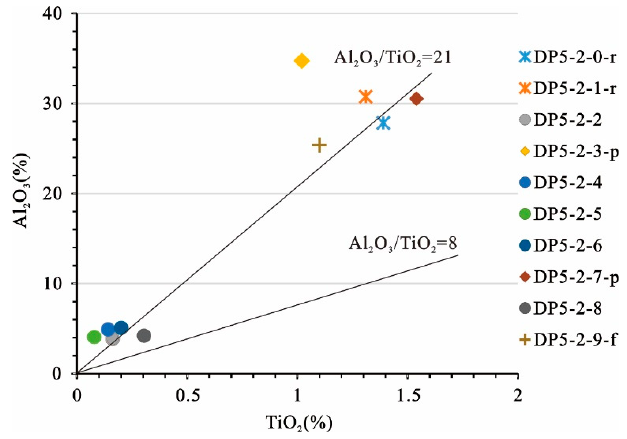
Figure 17. Plot of Al 2 O 3 versus TiO 2 for the coal bench, partings, roof, and fl oor samples from Dongpo Mine.